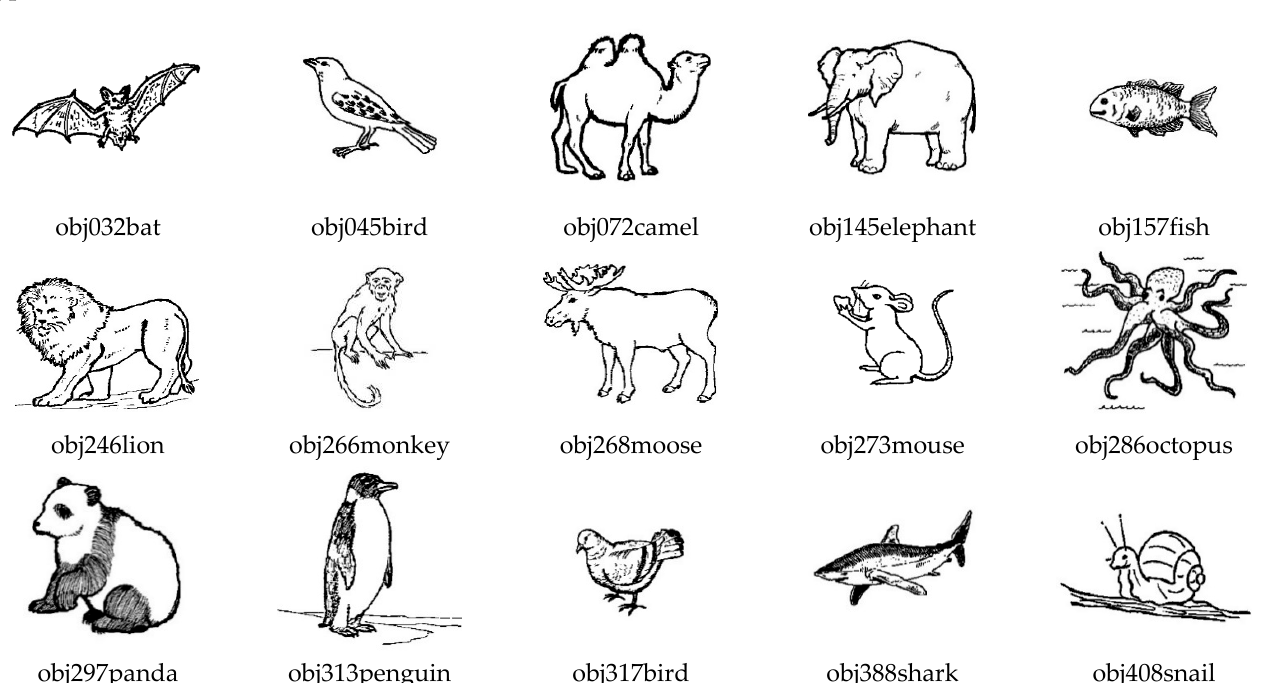
Figure A2. Uncivil pictures.